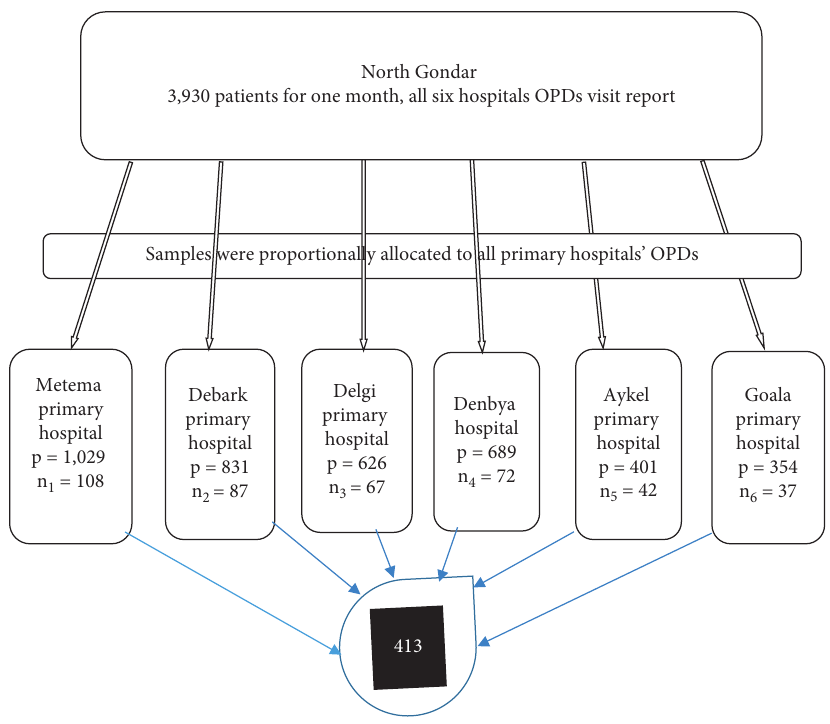
Figure 1: Schematic representation of sampling procedures for patient satisfaction and associated factors at primary hospitals of North Gondar,